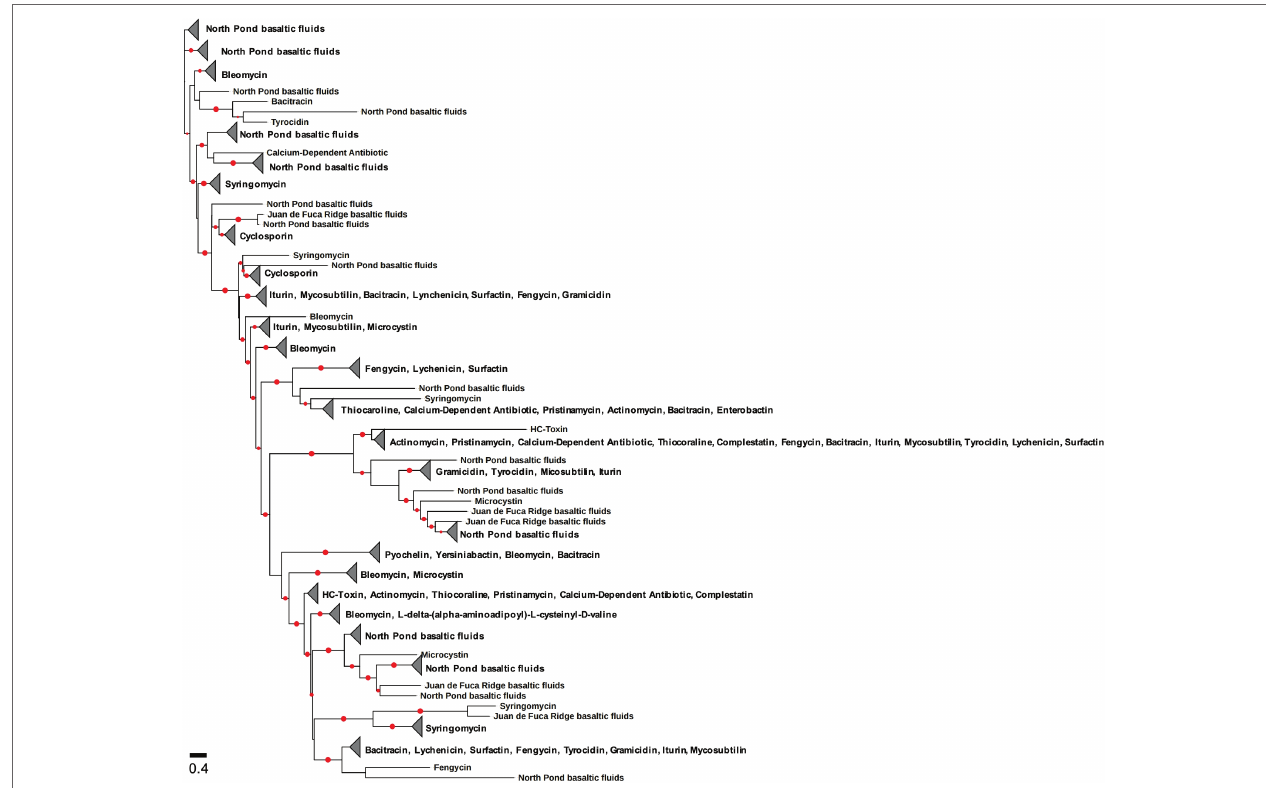
FIGURE 4 | Phylogenetic tree of the condensation domain of the NRPS gene including sequences from terrestrial deep subsurface and marine deep subsurface sites. The reference sequences are from the Natural Product Domain Seeker (NaPDoS) repository. The alignment and tree were built using the NaPDoS pipeline (Ziemert et al., 2012). Red dots indicate bootstrap values greater than